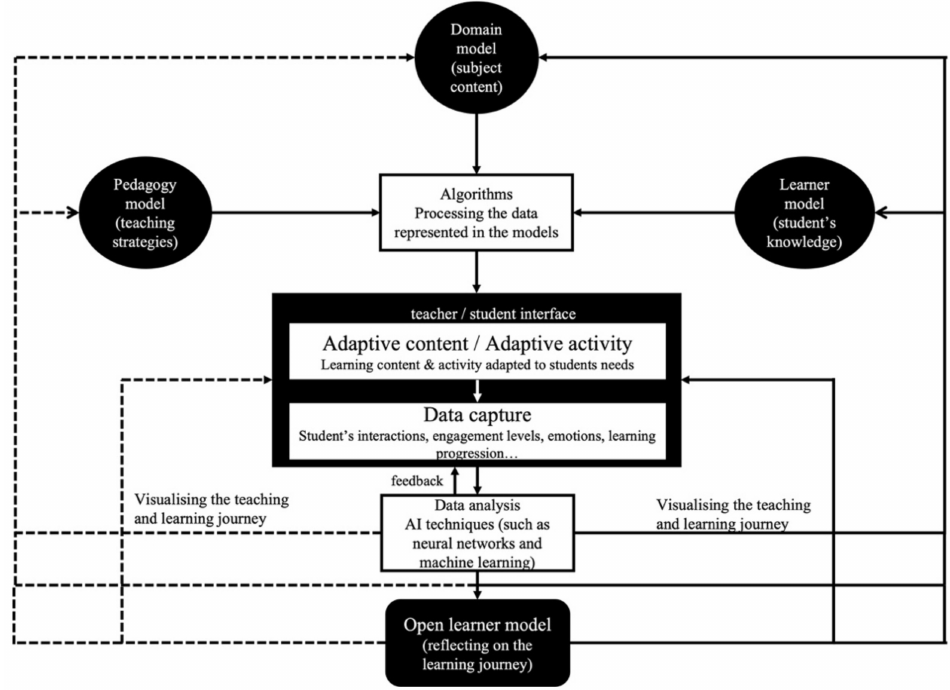
Figure 5. The interaction between the domain, pedagogy, learner, and open-learner models for providing adaptive support through an ITS (adapted from